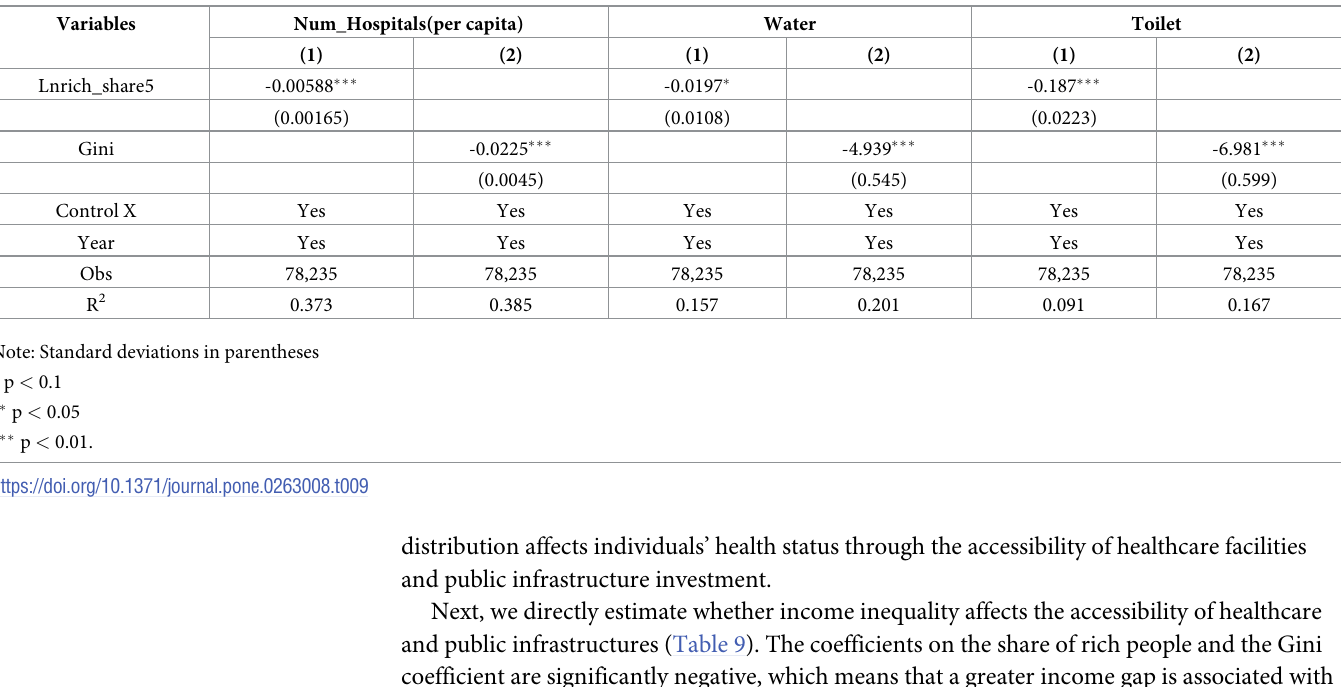
Table 9. The effects of income inequality on the provision of health facilities and public infrastructures.